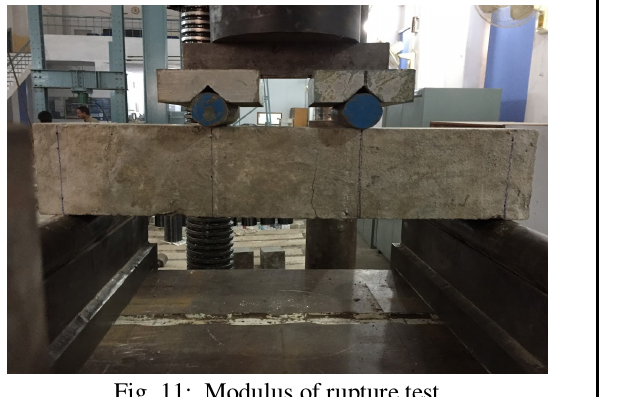
Fig. 11: Modulus of rupture test